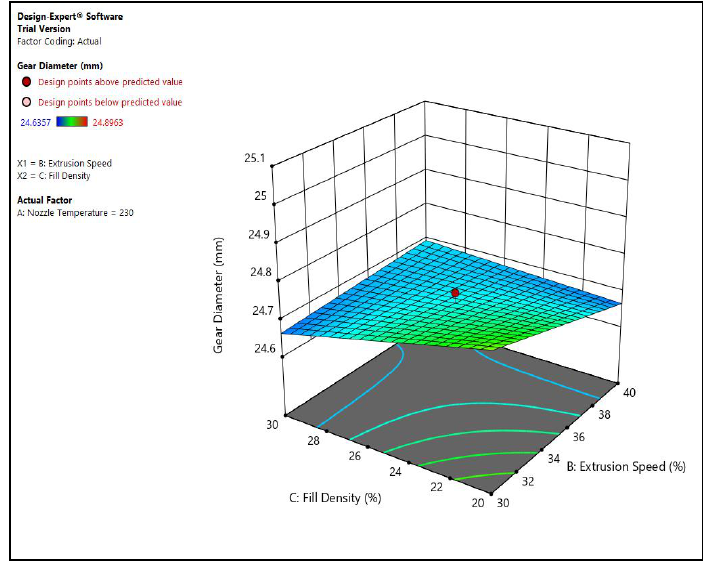
Fig. 6. Interaction effect analysis of factor B and C for the gear bore diameter.